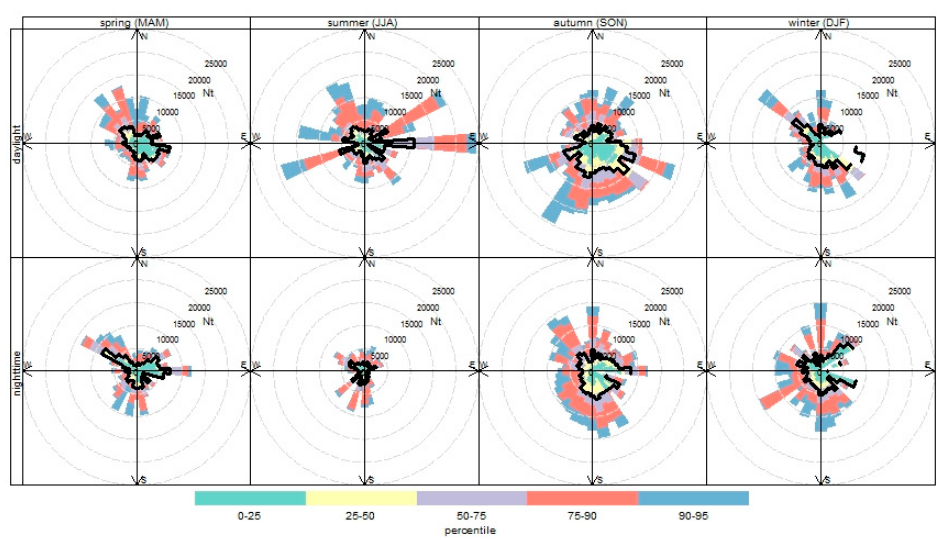
Figure 7. Percentile rose plot of Nt concentrations (particles cm − 3 ).